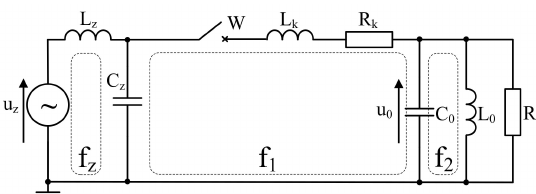
Figure 1. Equivalent scheme of a system phase with a transformer connected with a vacuum circuit breaker, where u z —source voltage; L z , C z —inductance and capacitance of the source circuit; f z —natural frequency of the source circuit; W—vacuum circuit breaker; L k , R k —inductance and resistance of cable line; f 1 —natural frequency of the cable line circuit; C 0 , L 0 , R 0 —equivalent parameters of capacitance, inductance, and resistance of the test object; f 2 —natural frequency of tested